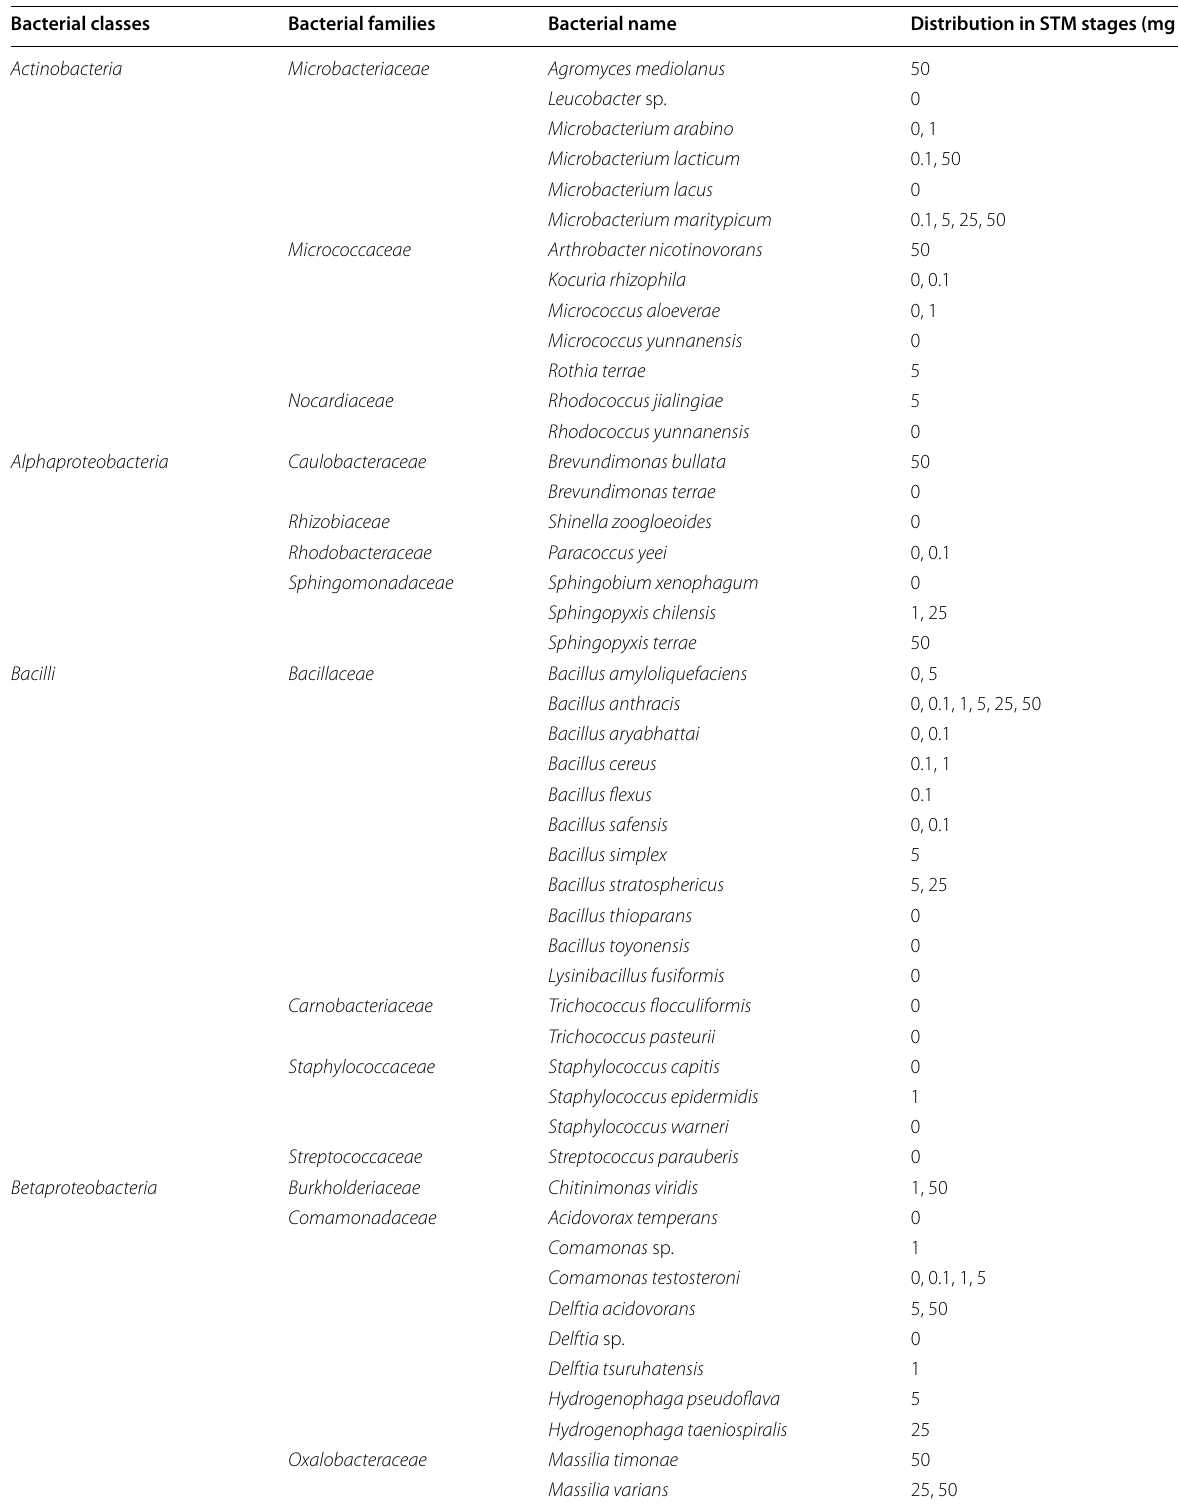
Table 1 Phylogenetic affiliation of bacterial isolates harvested from stepwise increasing doses of STM treating